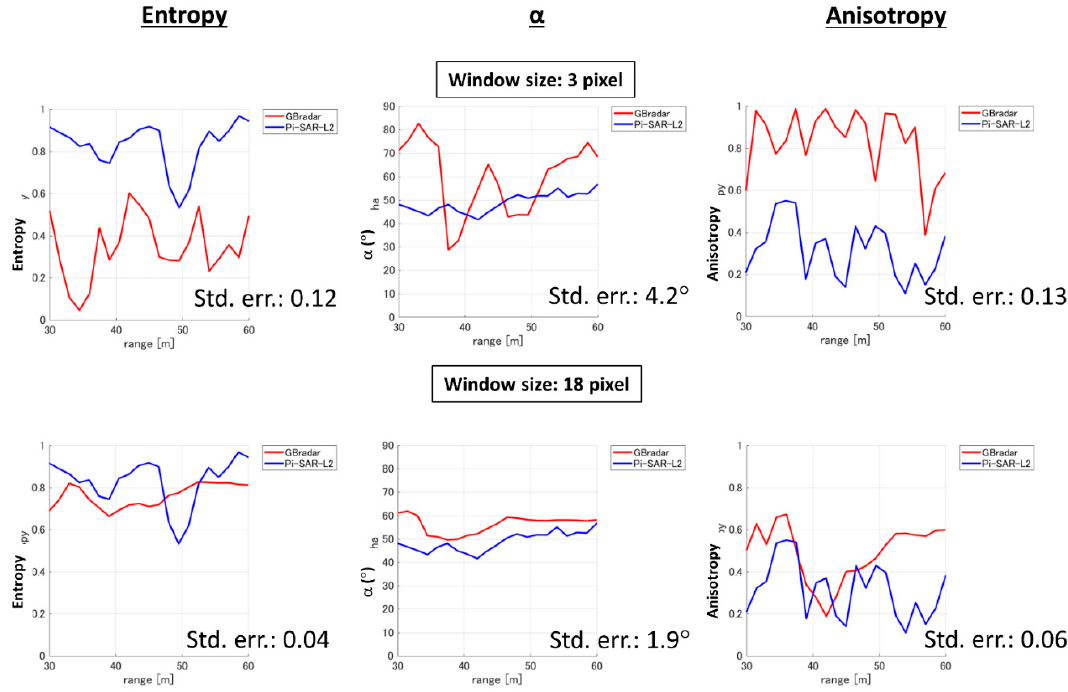
Figure 8. Range profiles at various entropy, α ; anisotropy values obtained from GB-radar ( red ) and Pi-SAR-L2 ( blue ). The window size is 3 pixels for Pi-SAR-L2 data, and 3 pixels ( Top ), and 18 pixels ( Bottom ) for GB-radar data.